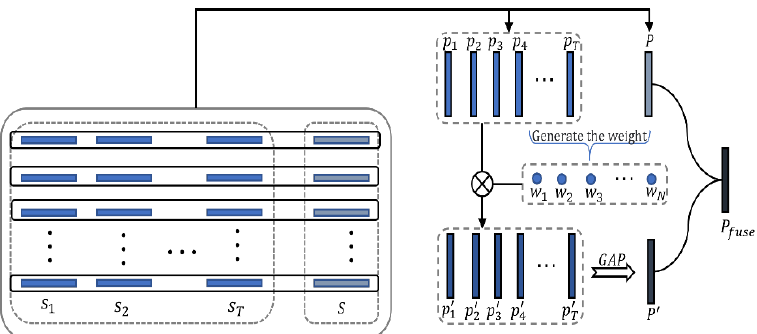
Figure 4. The structure of Metric-based Frame Attention Mechanism (MFAM). 𝑝 𝑡 and 𝑃 represent a set of human body parts feature vectors with frame-level features ( 𝑠 𝑡 ) and sequence-level features ( 𝑆 ), respectively.